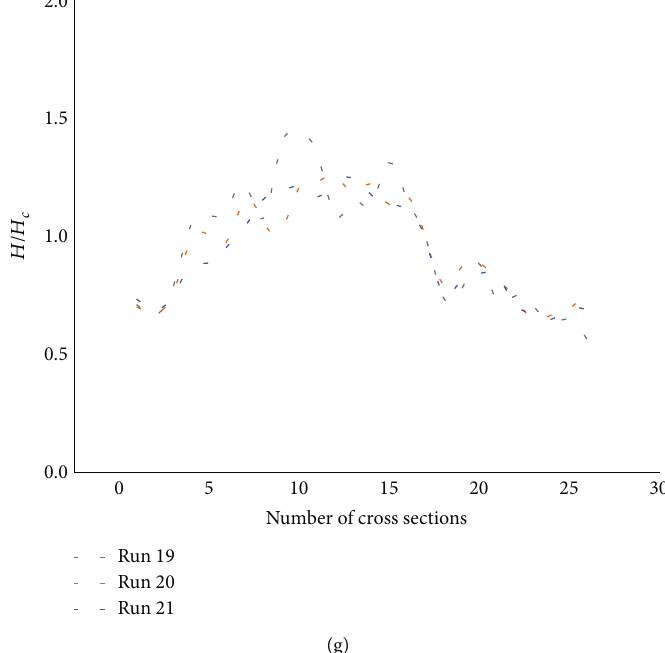
Figure 6: Free-surface longitudinal pro fi les of the curved spillway in the 21 runs. (a) Runs 1-3; (b) Runs 4-6; (c) Runs 7-9; (d) Runs 10-12; (e) Runs 13-15; (f) Runs 16-18; (g) Runs